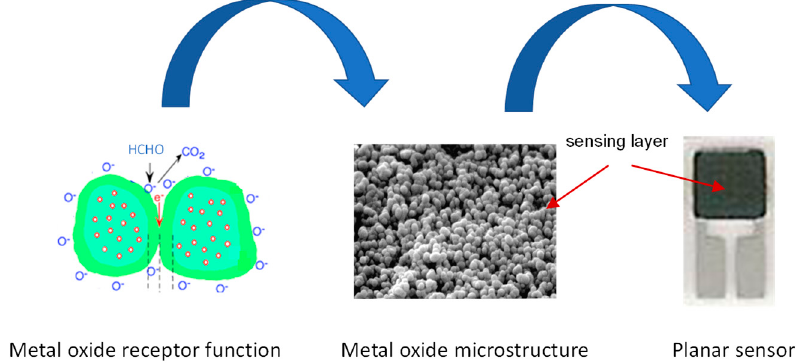
Figure 9. The functioning of an HCHO sensor detection.